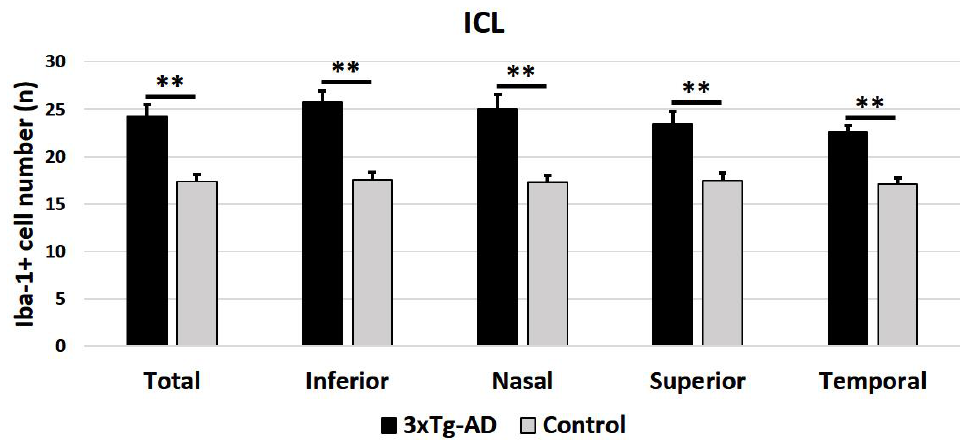
Figure 5. Number of Iba-1 + cells in the inner retinal layer complex (ILC) in the 3xTg-AD and in age-matched control mice in the di ff erent retinal zones (inferior, nasal, superior, and temporal), as well as in the total retina. A total of 192 images were analyzed for each study group (3xTg-AD and control). Histograms show the mean number ( ± standard deviation, SD) of Iba-1 + cells per area of 0.1502 mm 2 . Statistically significance indicators: ** p < 0.01.